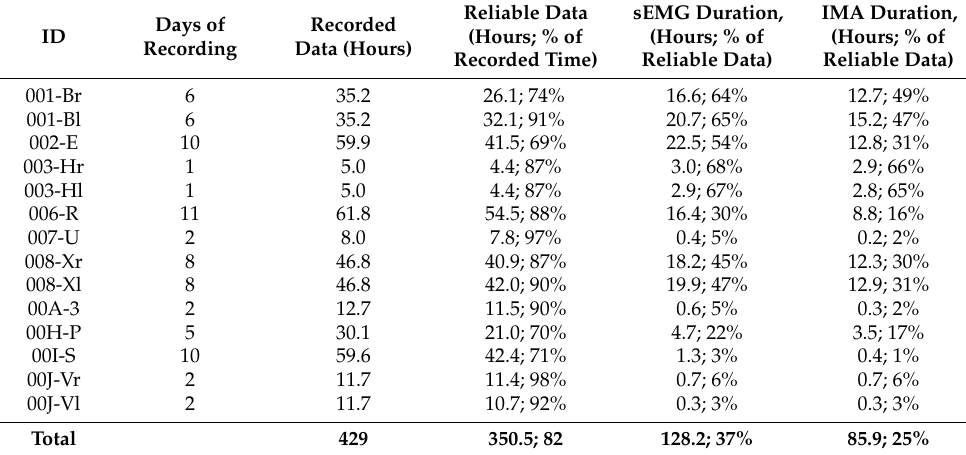
Table 1. Recorded hours, signal quality, sEMG duration and involuntary muscle activity (IMA) duration. sEMG refers to any presence of muscle activity, irrespective of the amount of upper limb acceleration recorded by the probe; IMA refers only to the presence of muscle activity without upper limb acceleration, with the patient at